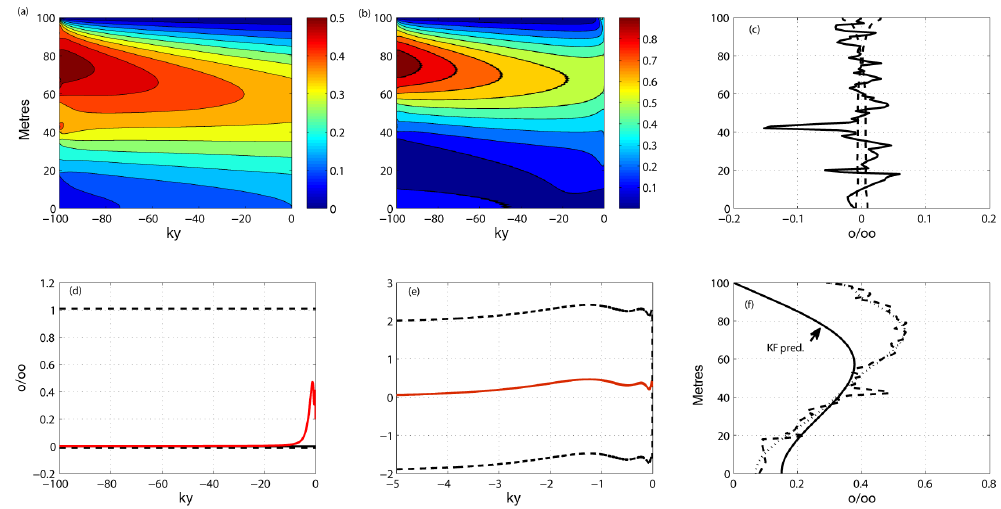
Figure 14. Results for Core 981 in the northeast Atlantic Ocean using a flat prior and quasi-periodic boundary conditions for a solution forced to produce the maximum at depth by uncertainty variance weighting.